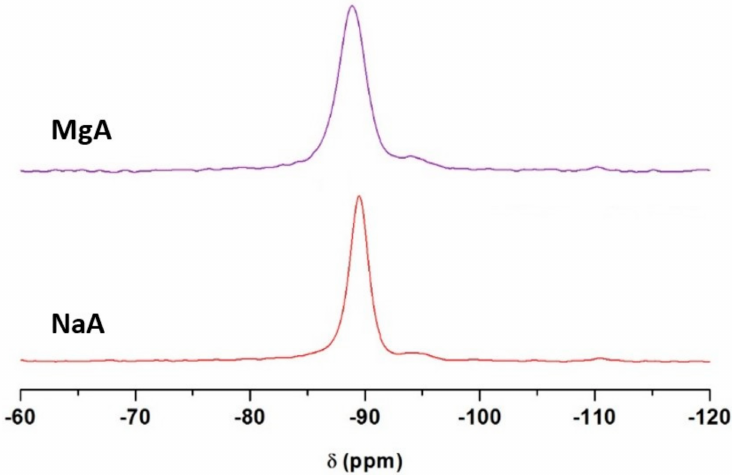
Figure 3. 29 Si MAS NMR spectra of NaA and MgA samples. Only the isotropic region is shown. One main resonance is detected at − 89.5 ppm and − 88.9 ppm for the NaA and MgA samples, respectively, corresponding to tetrahedral Si(OAl) 4 species typical of the LTA-type zeolite